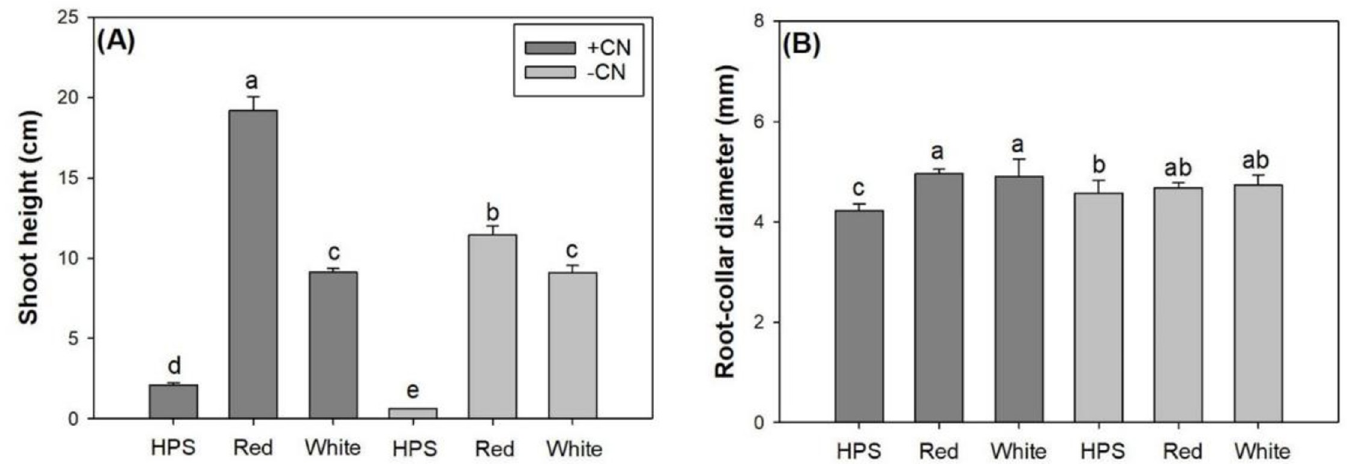
Fig 3. Shoot height (A) and root-collar diameter (B) in Eleutherococcus senticosus seedlings subjected to combined spectra and chitosan nanoparticle addition (CN) treatments. + CN, with CN addition; -CN, without CN addition; HPS, high-pressure sodium spectrum; Red, red-light light-emitting diode (LED) spectrum; White, white-light LED spectrum. Error bars present standard errors and different letters are given over means with differences identified by Turkey test ( α < 0.05).